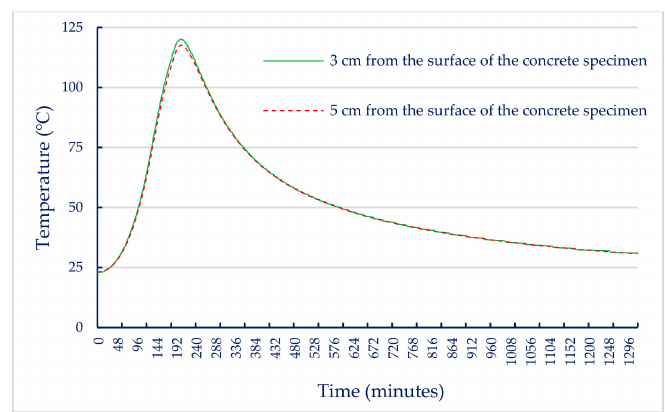
Figure 7. Relationship between specimen internal temperature and time (target temperature = 300 ◦ C).